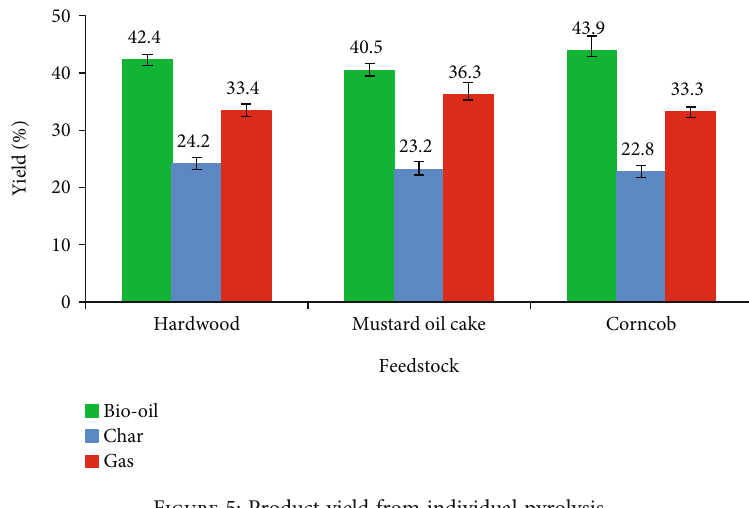
Figure 5: Product yield from individual pyrolysis.